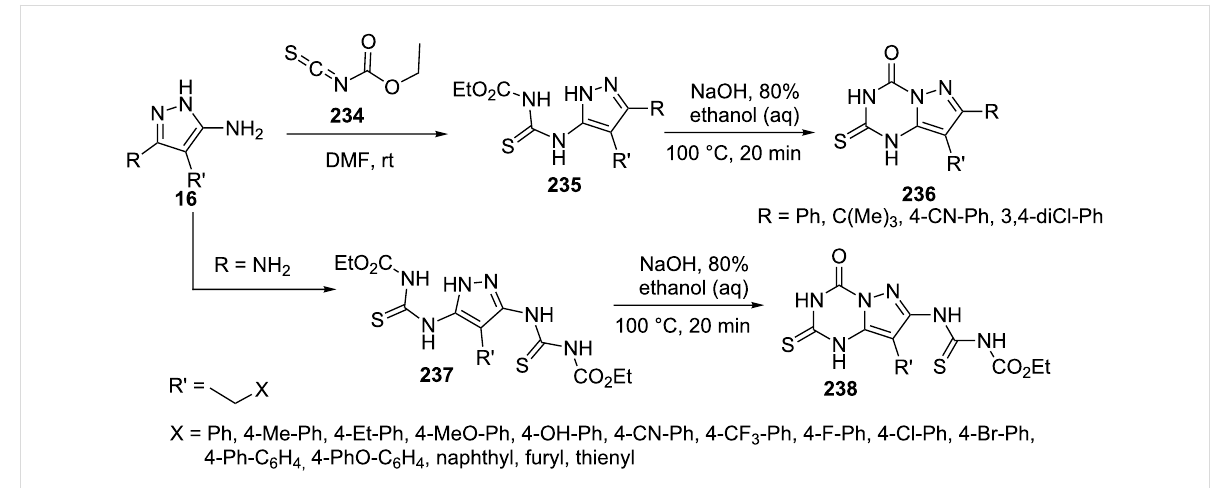
Scheme 64: Synthesis of 2-thioxo-pyrazolo[1,5- a